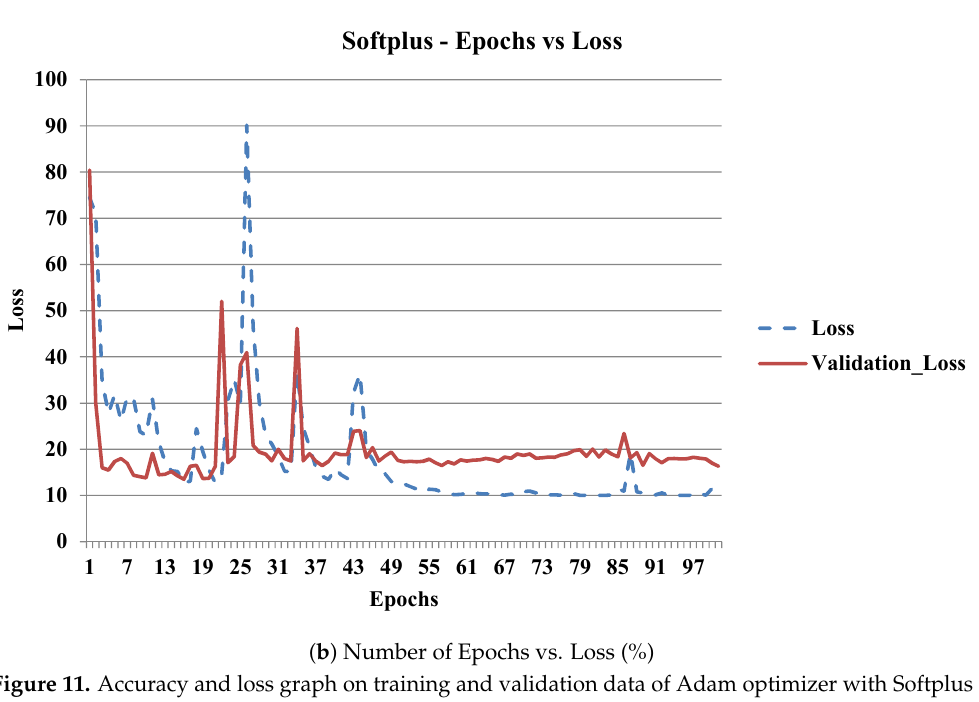
Figure 11. Accuracy and loss graph on training and validation data of Adam optimizer with Softplus activation function.